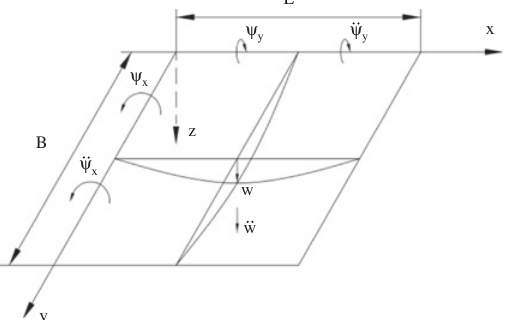
Figure 1: Displacements of rectangular